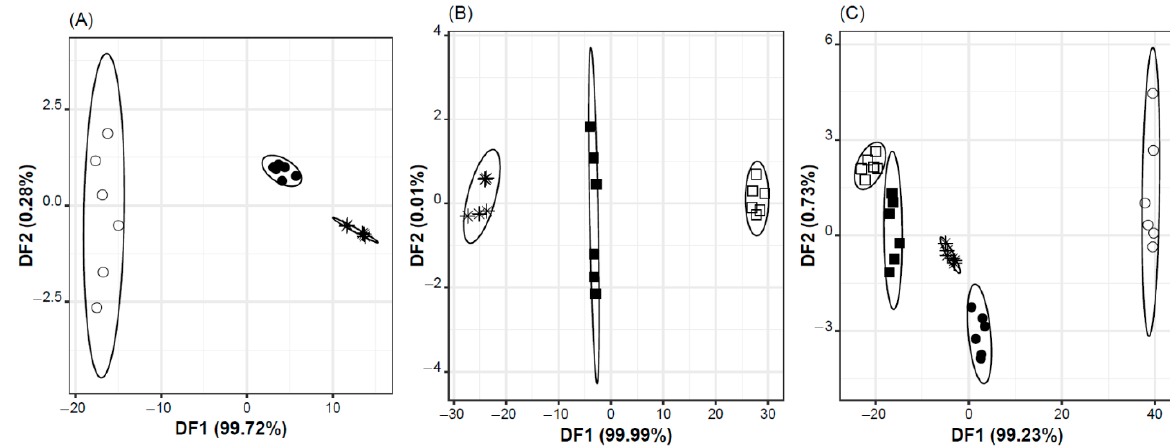
Figure 1. Supervised LDA discrimination of oral formulations, syrup and water with and without ranitidine (oral formulation without ranitidine ( □ ); oral formulation with ranitidine ( ■ ); syrup without ranitidine ( ○ ); syrup with ranitidine ( ● ); and/or, water with ranitidine (*)) based on non-redundant potentiometric signals of E-tongue sensors, selected by the SA algorithm. ( A ) LDA-SA-E-tongue model based on two E-tongue sensors (S2:11 and S2:12). ( B ) LDA-SA-E-tongue model based on two E-tongue sensors (S2:9 and S2:13). ( C ) LDA-SA-E-tongue model based on three E-tongue sensors (S1:11, S2:5 and S2:11).